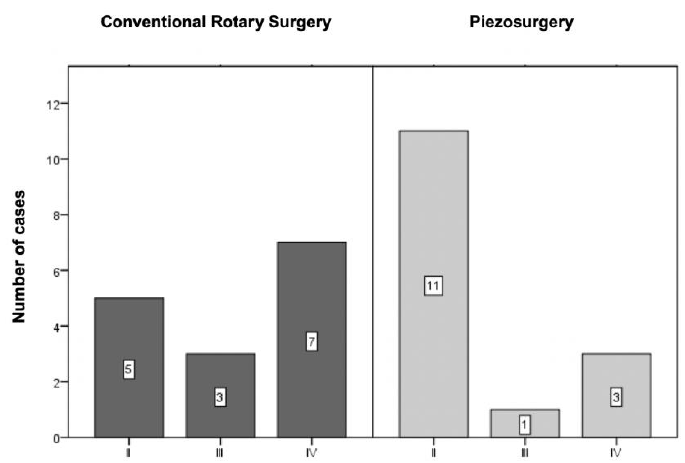
Figure 3. Sample distribution according to Winter’s classification ( p = 0.397 for the comparison be- tween the two techniques).